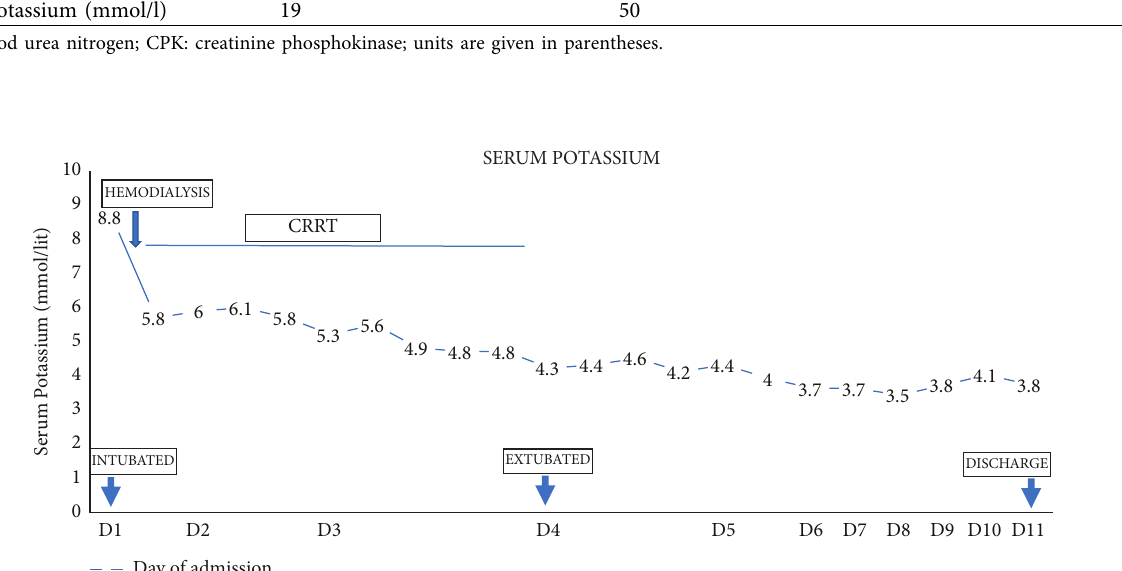
Figure 2: Course of hospitalisation with serum potassium levels.